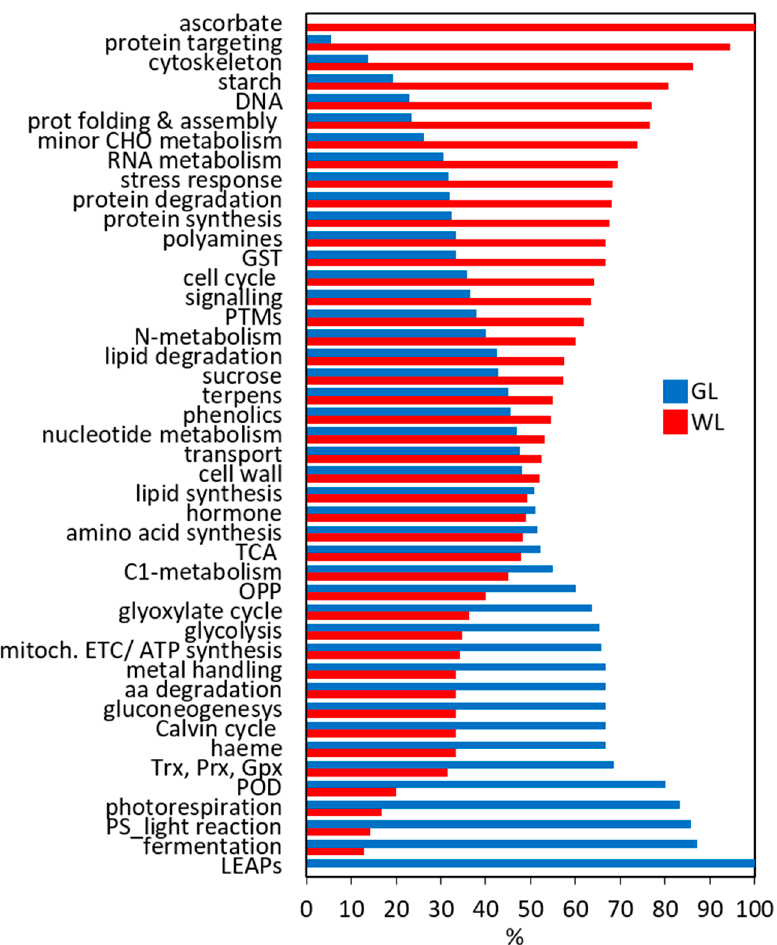
Figure 2. Functional classes of upregulated genes in P. zonale GL (blue bars) and WL (red bars). For a detailed classification of DEGs, see Supplementary Table S5. Gpx, glutathione peroxidases; GSTs, glutathione S -transferases; LEAPs, late embryogenesis abundant proteins; OPP, oxidative pentose-phosphate pathway; Prx, peroxiredoxins; PODs, class III peroxidases; PS, photosynthesis; PTMs, post-translational modifications; ox-red, oxidoreductases; TCA, tricarboxylic acid cycle; Trx, thioredoxins.